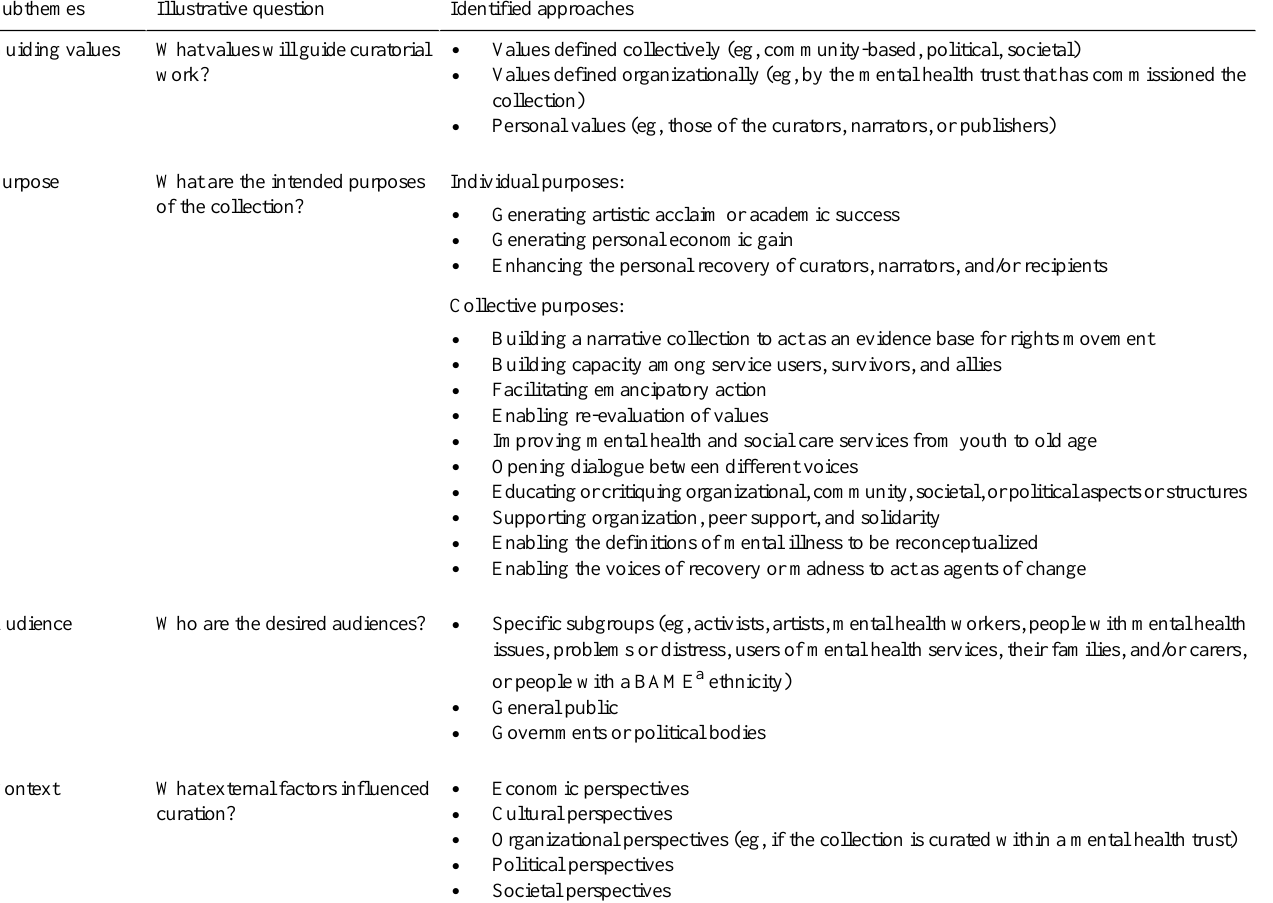
Table 2. Values and motivations in creating a